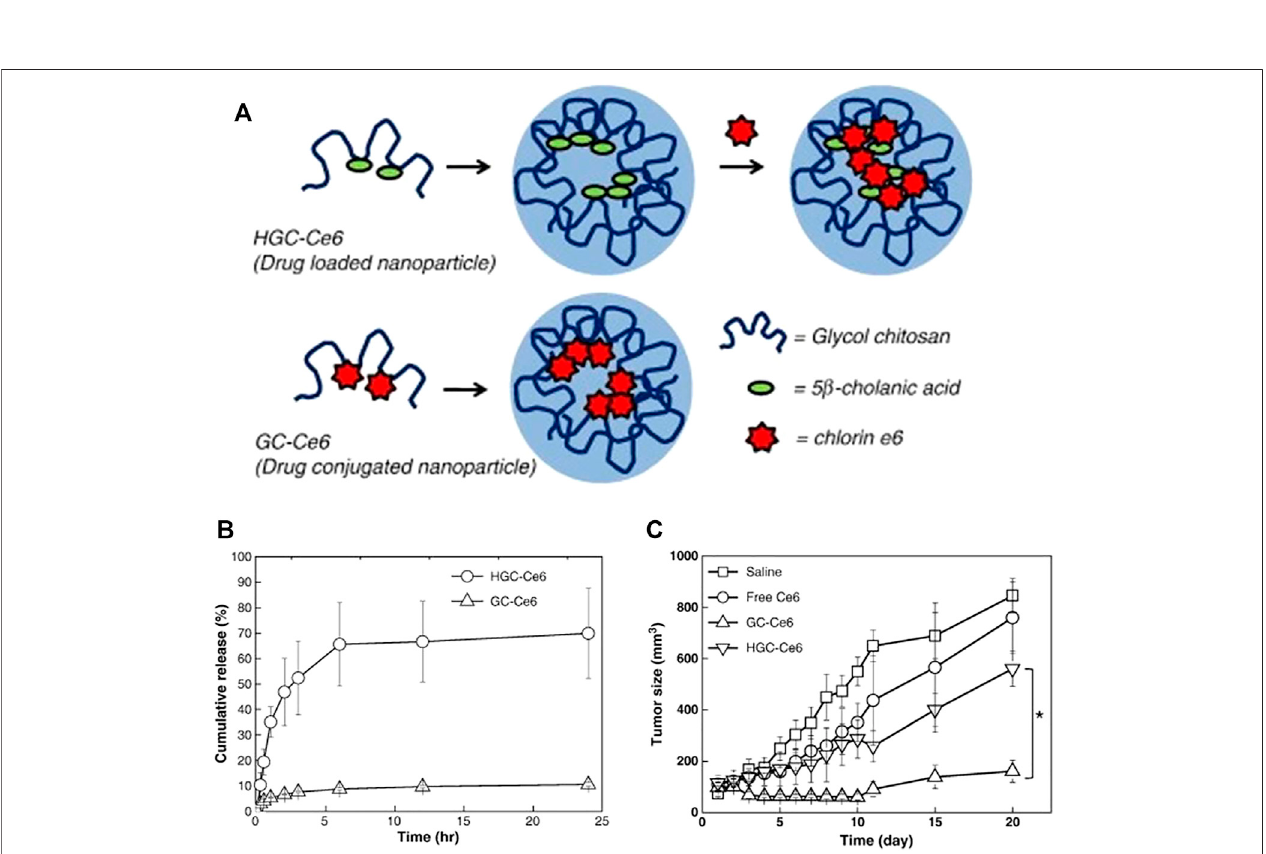
FIGURE 5 | Preparation of HGC-Ce6 and GC-Ce6 and release pro fi les and in vivo therapeutic ef fi cacy. (A) Schematic illustration of HGC-Ce6 (drug-loaded nanoparticle) and GC-Ce6 (drug-conjugated nanoparticle); (B) In vitro release pro fi les of HGC-Ce6 and GC-Ce6; (C) Tumor growth data after photodynamic therapy with free Ce6, HGC-Ce6, or GC-Ce6 (5 mg/kg of Ce6) in HT-29 tumor-bearing mice (Lee et al., 2011). Copyright (2011) Elsevier.